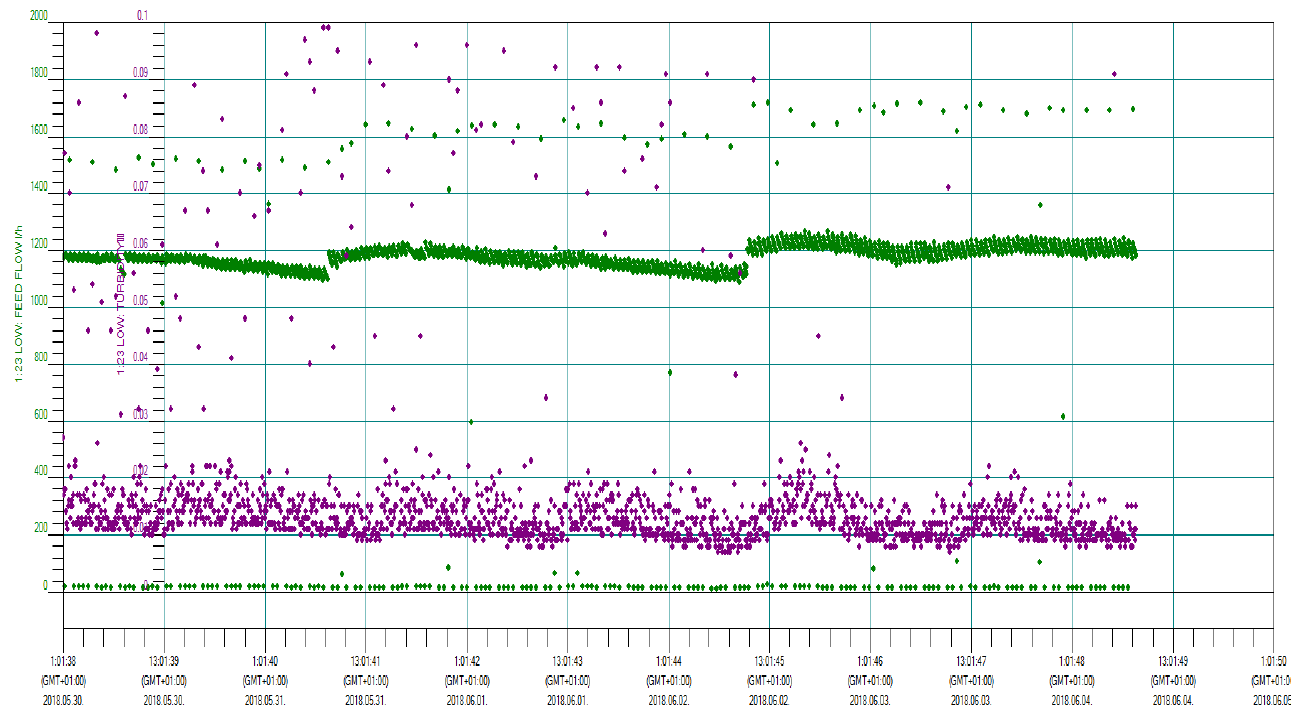
Figure A12. Flow and temperature at 105 l/m 2 h.